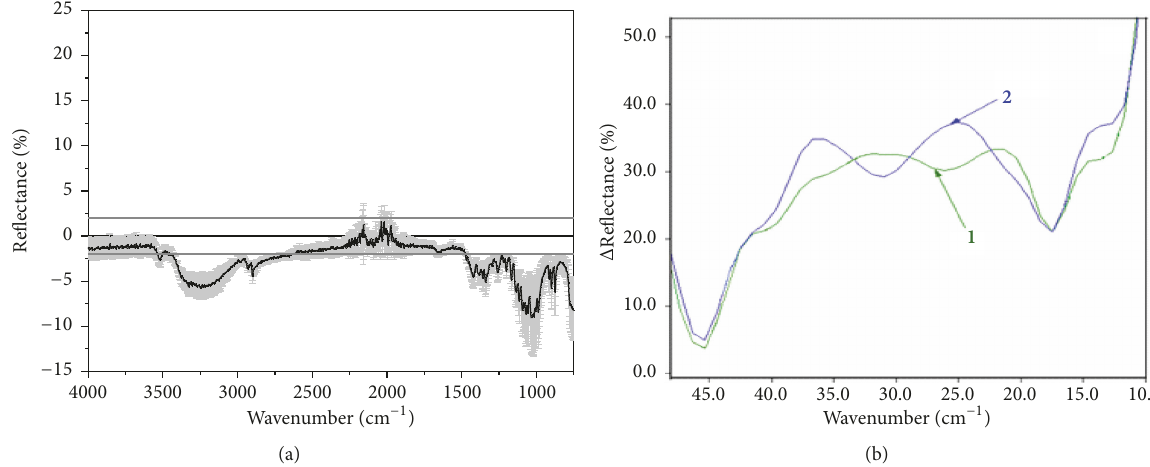
Figure 3: Differential IR spectra with the means of standard deviation (gray area) in the middle range (a) and in the terahertz range (b) for the sample of the native lactose (1) and lactose after the fluidization chamber (2) . Δ Reflectance = Reflectance of native sample – Reflectance of the sample after fluidization chamber .